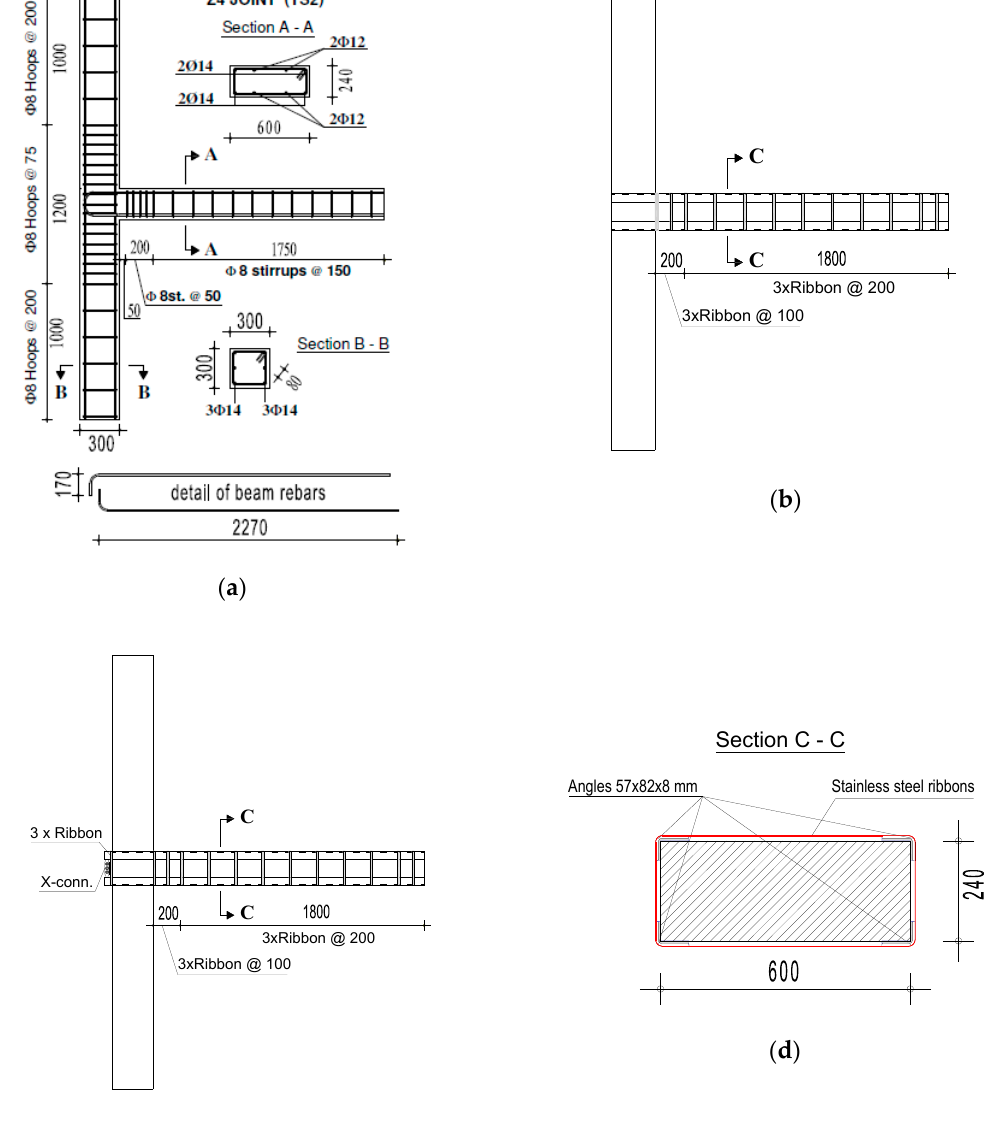
Figure 4. ( a ) Detailing of tested (Z4) as-built joint specimen TS2, ( b ) strengthening solution for TS9 specimen, ( c ) strengthening solution for TS10 specimen, ( d ) cross section view of the beam in strengthened specimens.